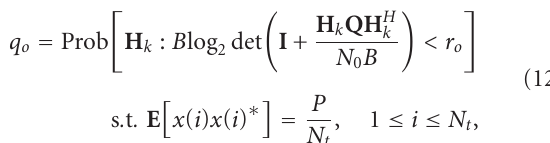
associated with receiver k is given by: